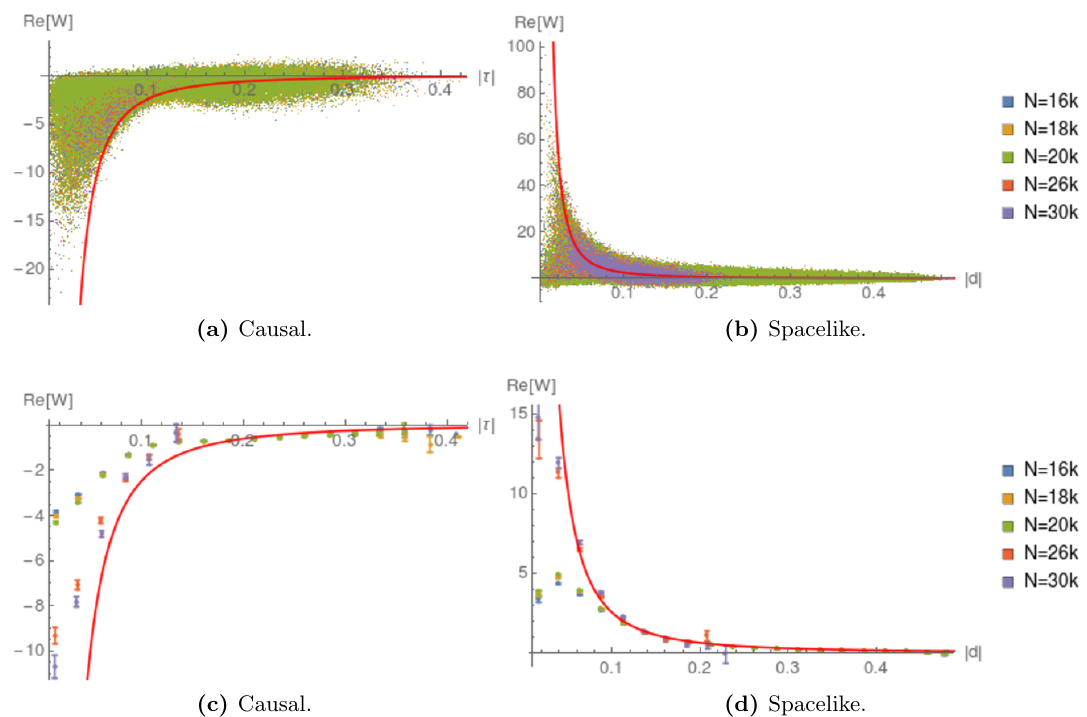
Figure 8. (a)-(b) represent Re[ W ] vs. geodesic distance for all pairs within a sub-diamond with SJ height 1 = 2 of the full diamond, in the 4d causal diamond; m = 0. (c)-(d) are plots of the binned and averaged data with the SEM. In both cases, the continuum Minkowski Wightman function (5.3) has also been shown.